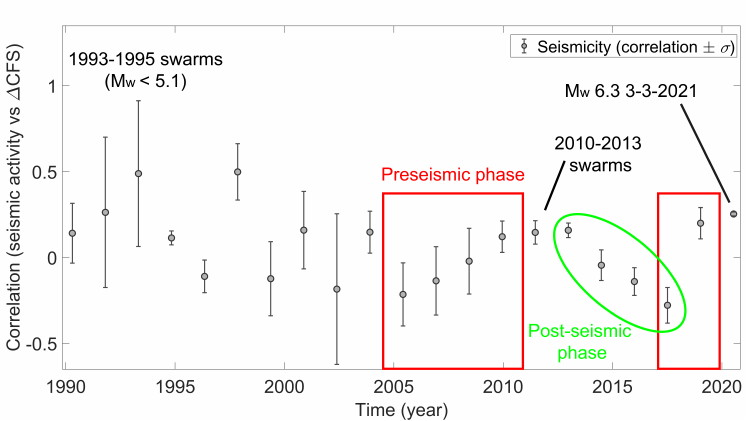
Figure 1. Correlation between ∆ CFS and seismicity in Thessaly Greece, between 1990 and 2021, M L > 2.0, NOAIG